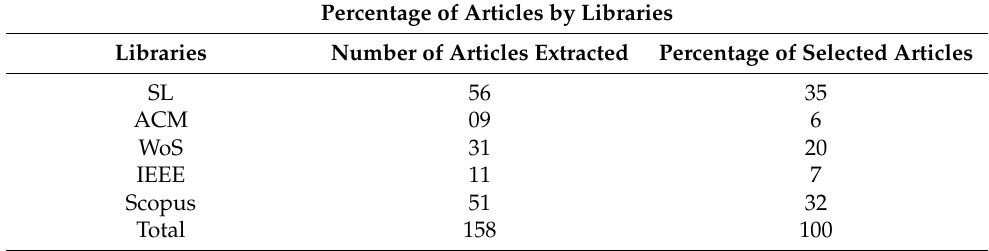
Table 9. Percentage of articles by